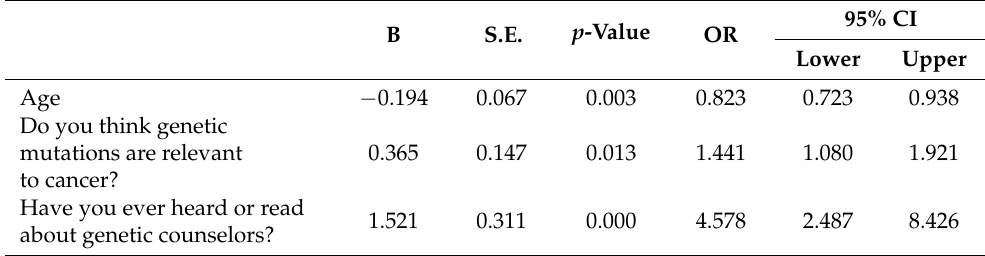
Table 4. Multivariate analysis of significant variables influencing awareness of family and inherited cancer ( p <